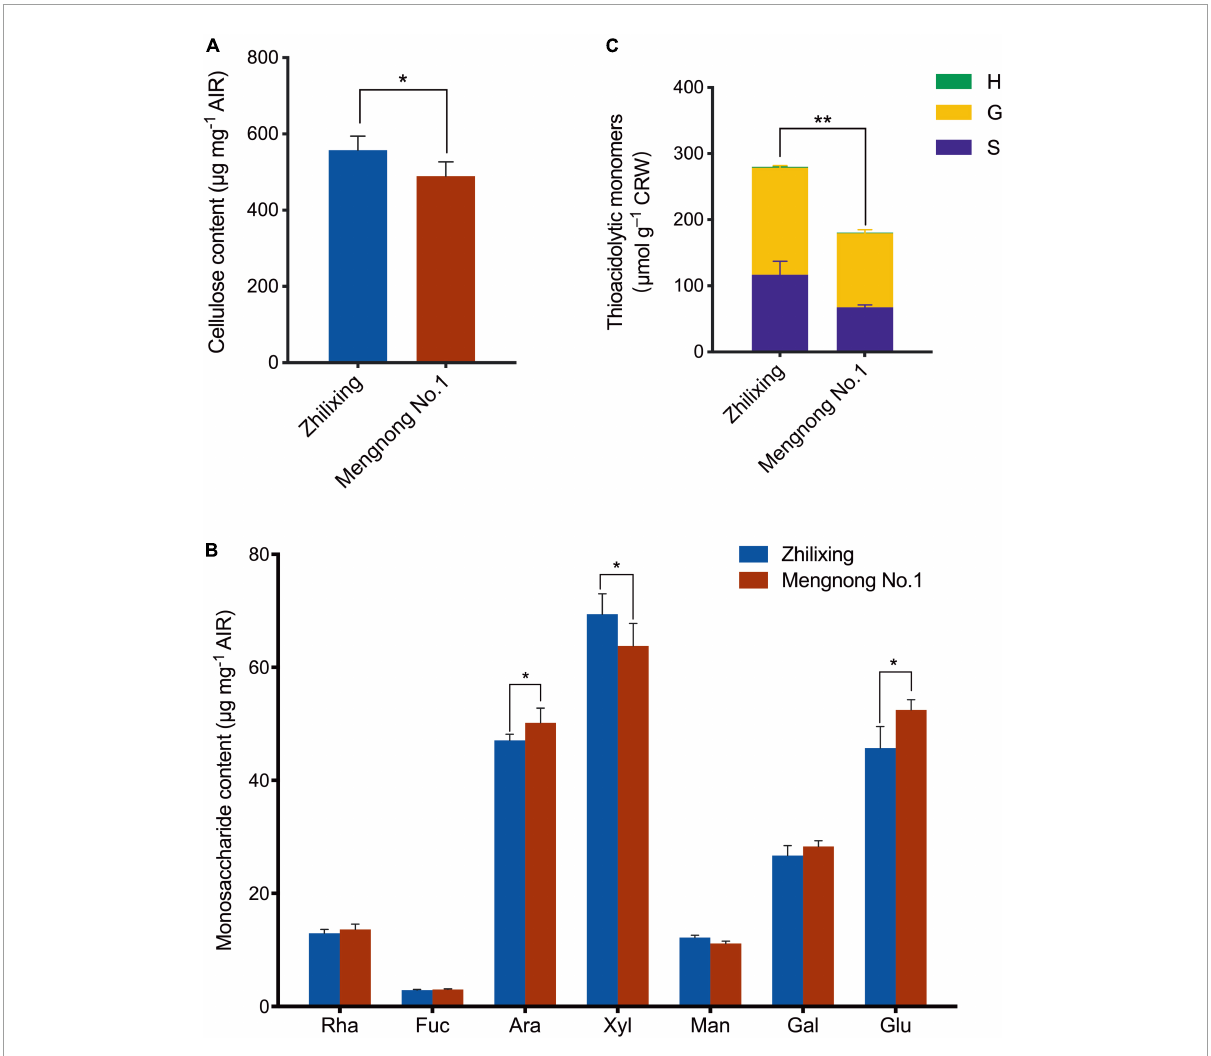
FIGURE2 Measurement of cell wall composition in the M. ruthenica cultivars Zhilixing and Mengnong No.1. (A,B) Determination of polysaccharides content in the M. ruthenica cultivars Zhilixing and Mengnong No.1. (A) , cellulose content (B) , neutral monosaccharides (Rha, rhamnose; Fuc, Fucose; Ara, Arabinose; Xyl, Xylose; Man, Mannose; Gal, Galactose; Glu, Glucose). In (A,B ), values are means ± S.D. of six biological replicates. Asterisks indicate significant differences between the two cultivars, as determined by Student’s t -test (* P < 0.05). (C) Determination of lignin composition and content in the two M. ruthenica cultivars. Values are means ± S.D. of six biological replicates. Asterisks indicate significant differences in G-, S-lignin and total lignin content between the two cultivars, as determined by Student’s t -test (** p < 0.01).